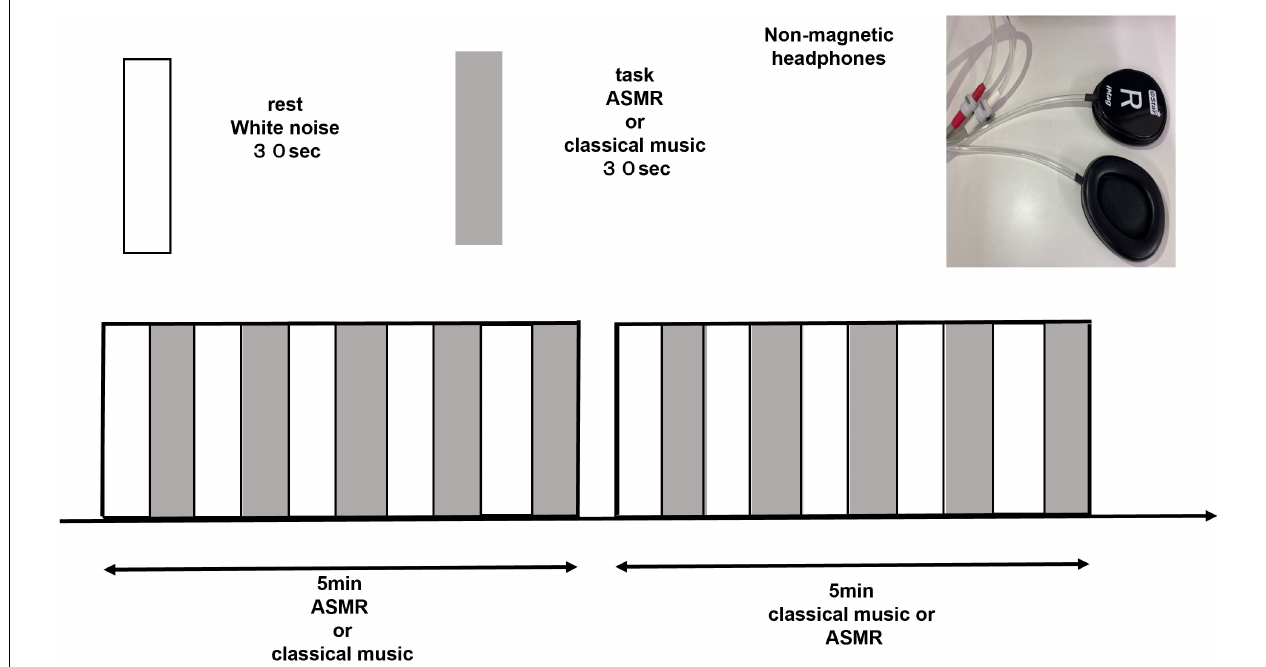
FIGURE 1 | Block design of 5-min with a 30-s rest and a 30-s task repetition (ASMR, classical music). Each subject listened to ASMR stimulation and classical music in random order. ASMR, autonomous sensory meridian